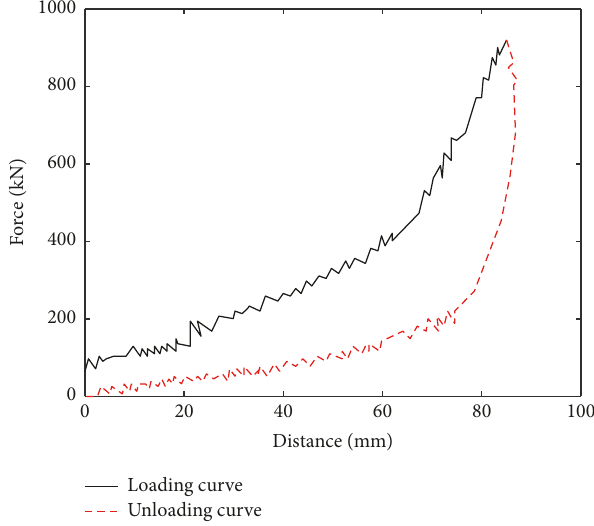
Figure 6: Performance curve of the buffer of the head vehicle.